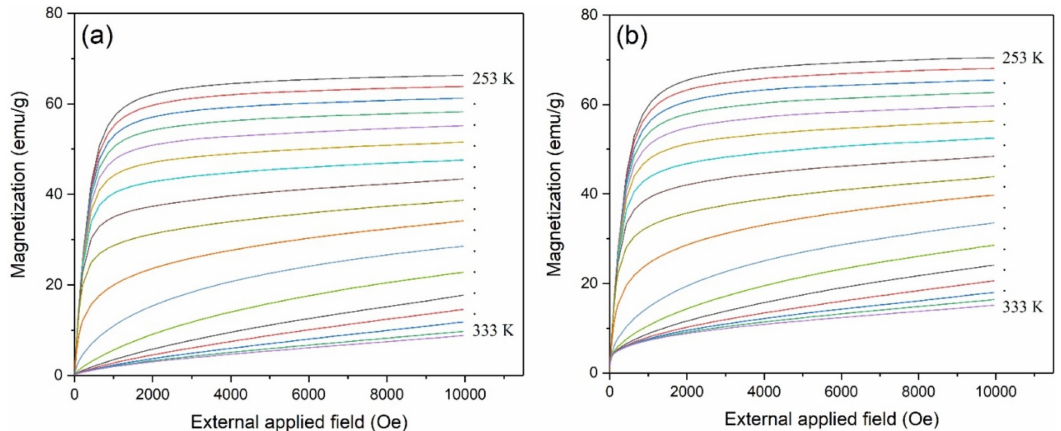
Figure 7. Isothermal magnetization curves of ( a ) as-sintered Ni 50 Mn 33 In 16 Cr 1 alloy and ( b ) 2 h CoFe-coated Ni 50 Mn 33 In 16 Cr 1 /Cu alloy at 253 to 333